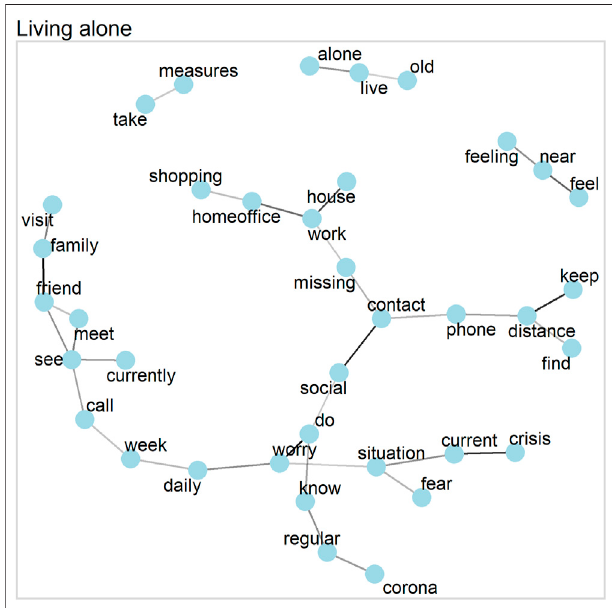
FIGURE 5 | Word network for those living alone (correlations >